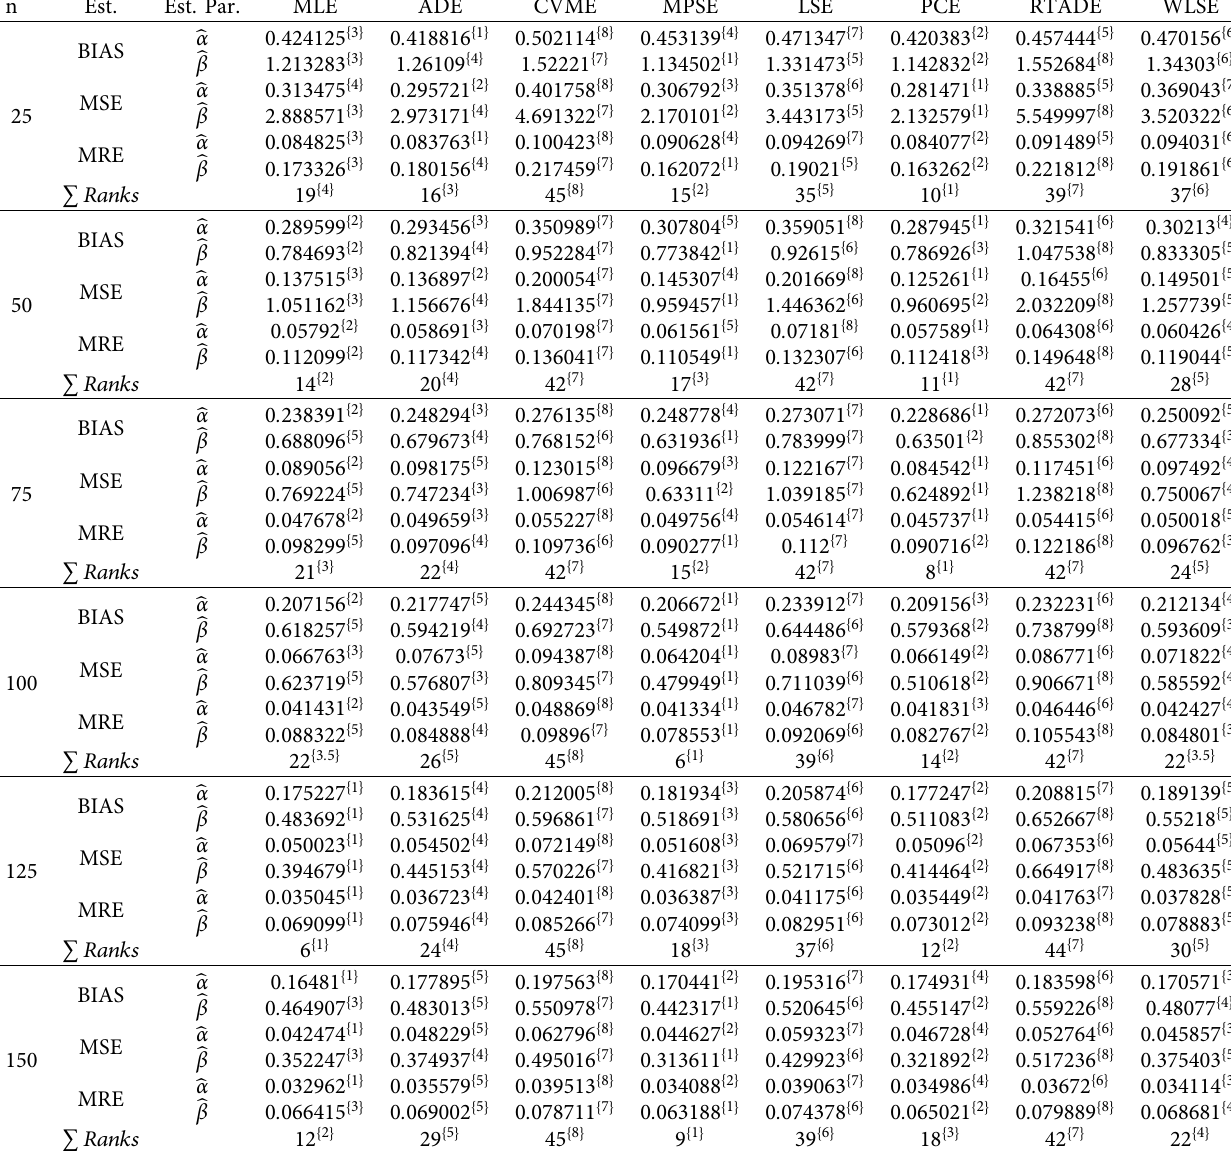
Table 5: Simulation values of BIAS, MSE, and MRE for α � 5 , β �